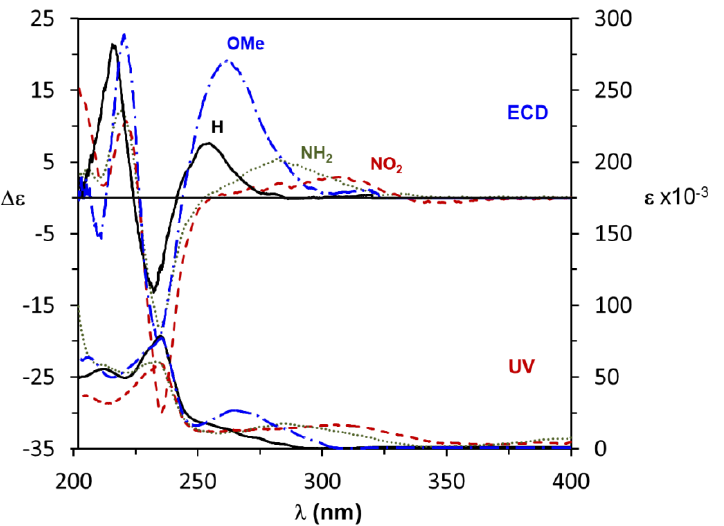
Figure 6. UV and ECD spectra of biphenylamides ( S )- 4ba (solid black line), ( S )- 4bb (dashed dotted blue line), ( S )- 4bc (dashed red line) and ( S )- 4bd (dotted green line).